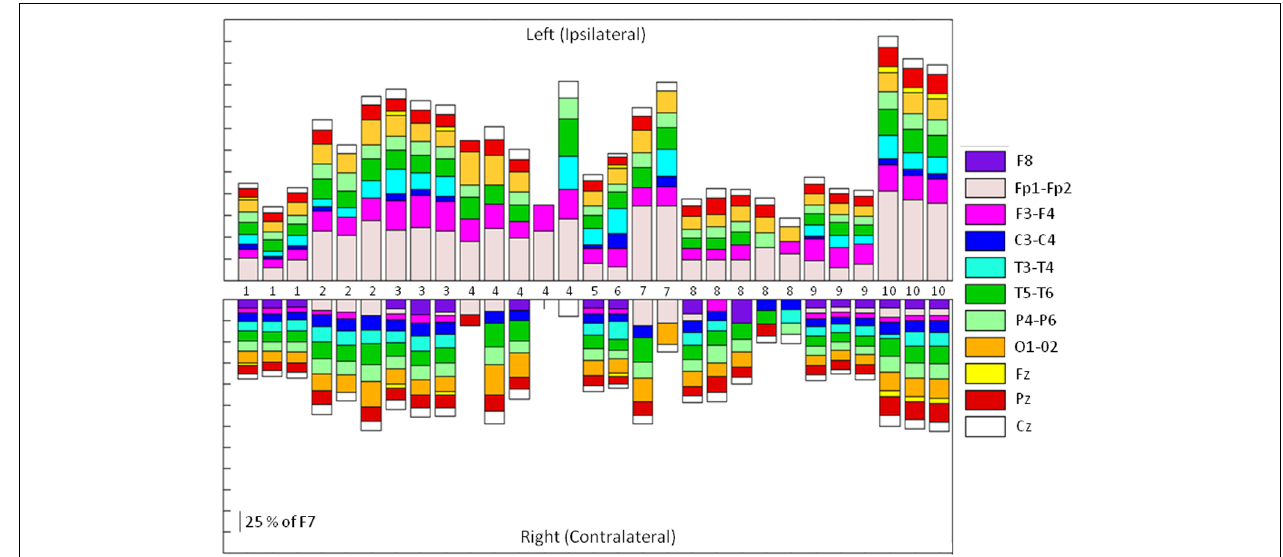
FIGURE 5 | Relative sizes of the SMU representation on different EEG electrodes. Stacked bar representation of the percentage contribution of 29 SMU-trains to Left and Right Side EEG electrodes. Each of the 29 SMU trains is represented as a bar in horizontal axis. Macro-EMEG representation in electrode F7 was taken as 100 percent and SMU